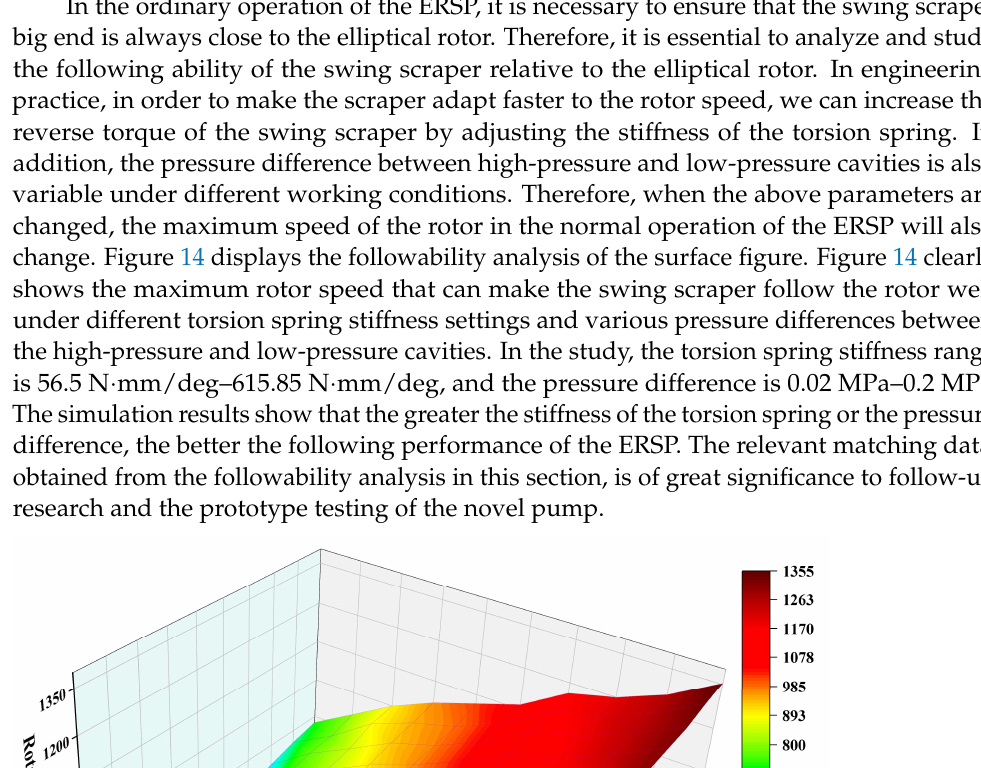
Figure 13. The curve of contact force.